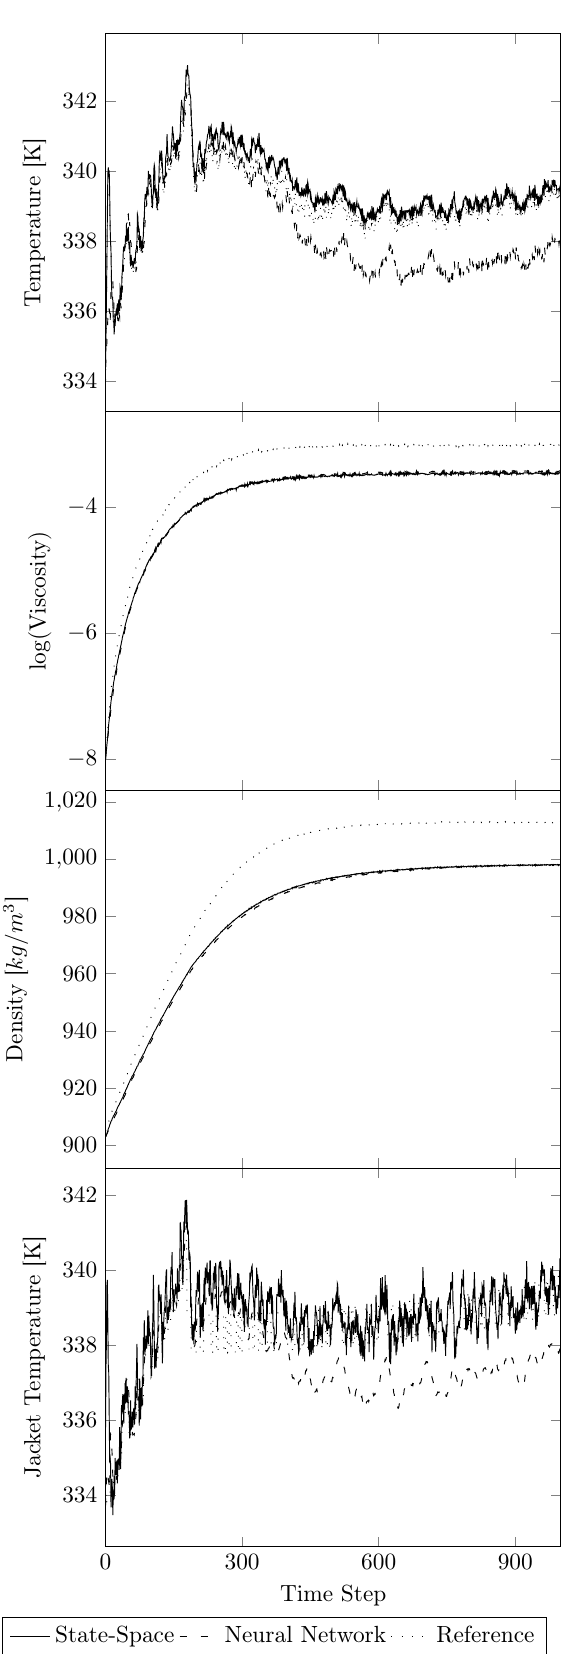
Figure 9. Implementation of state-space models and NARX networks into MPC subject to measure- ment